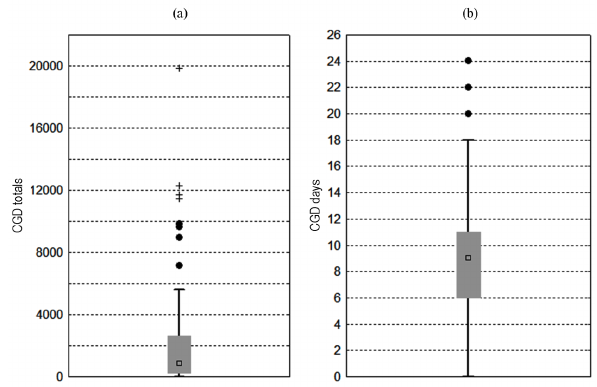
Fig. 3. Box-plots of the distributions of (a) monthly CGD totals; (b) Figure 3. Box-plots of the distributions of (a) monthly AEDCGD totals; (b) monthly 654 monthly number of CGD days in 2003–2009 over Portugal. Box lower (upper) limits correspond to the 25th (75th) percentile and number of AEDCGD days in 2003-2009 over Portugal. Box lower (upper) limits 655 lower (upper) whisker limits correspond to the non-outlier minima correspond to the 25 th (75 th ) percentile and lower (upper) whisker limits correspond to 656 (maxima). Medians are indicated by squares. Outliers (extremes) are values above the upper box limits of at least 1.5 (3.0) × IQR the non-outlier minima (maxima). Medians are indicated by □. Outliers (extremes) are 657 (interquartile range or box height) and are indicated by circles values above the upper box limits of at least 1.5 (3.0) x IQR (interquartile range or box 658 height) and are indicated by • (+). 659